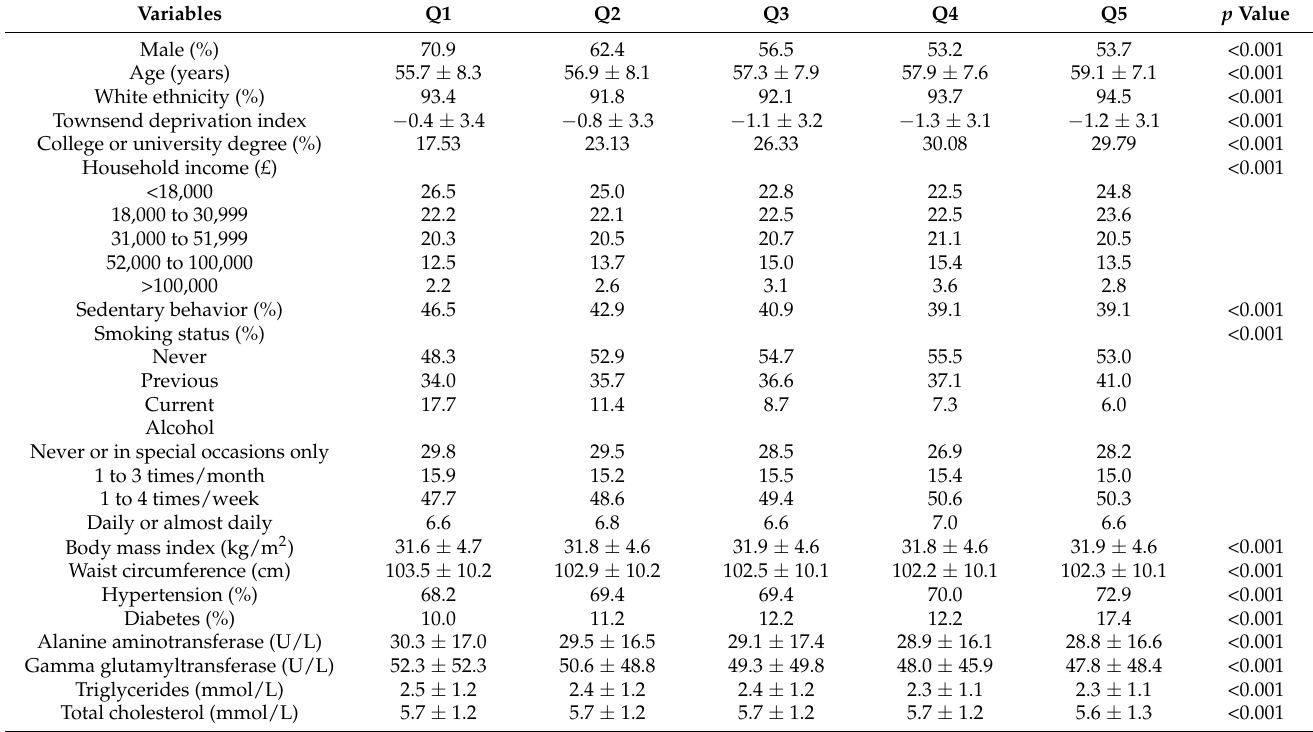
Table 1. UK Biobank participants’ characteristics by the diet quality score.